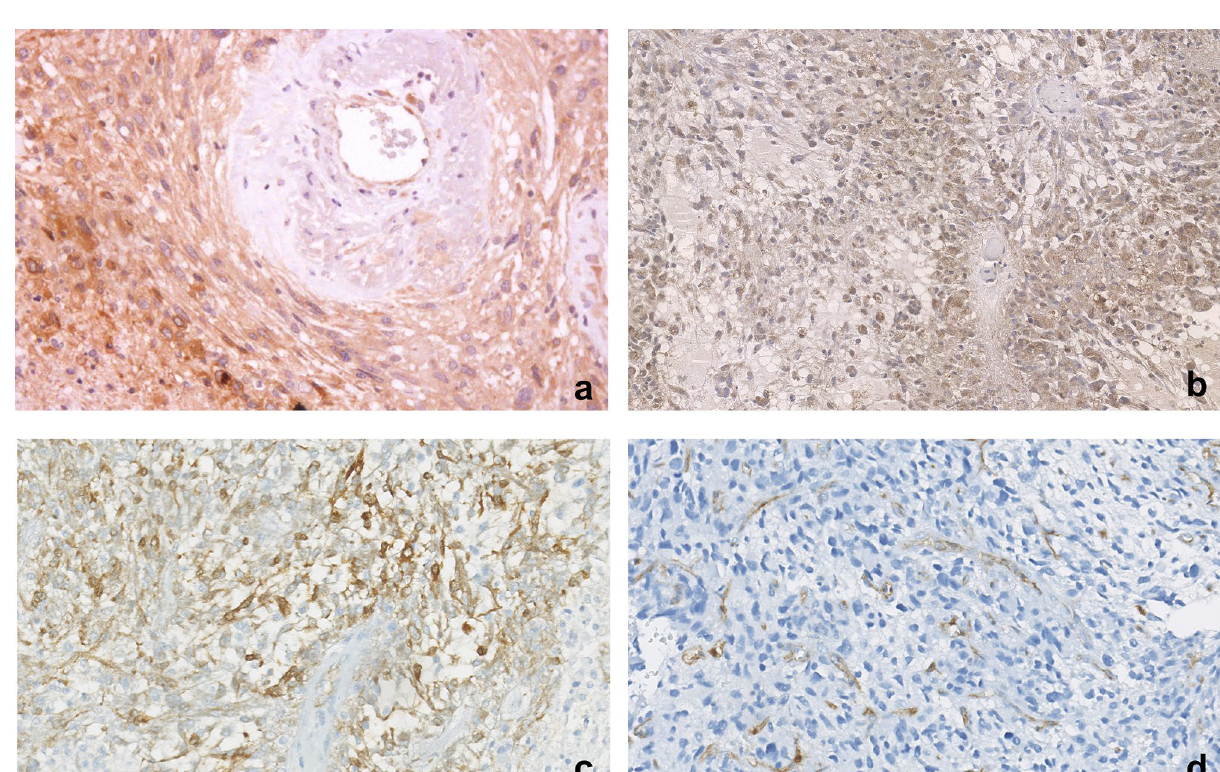
Figure 3. Kaplan–Meier analysis of survival curves according to concomitant c-Met/VEGFR2 expression.